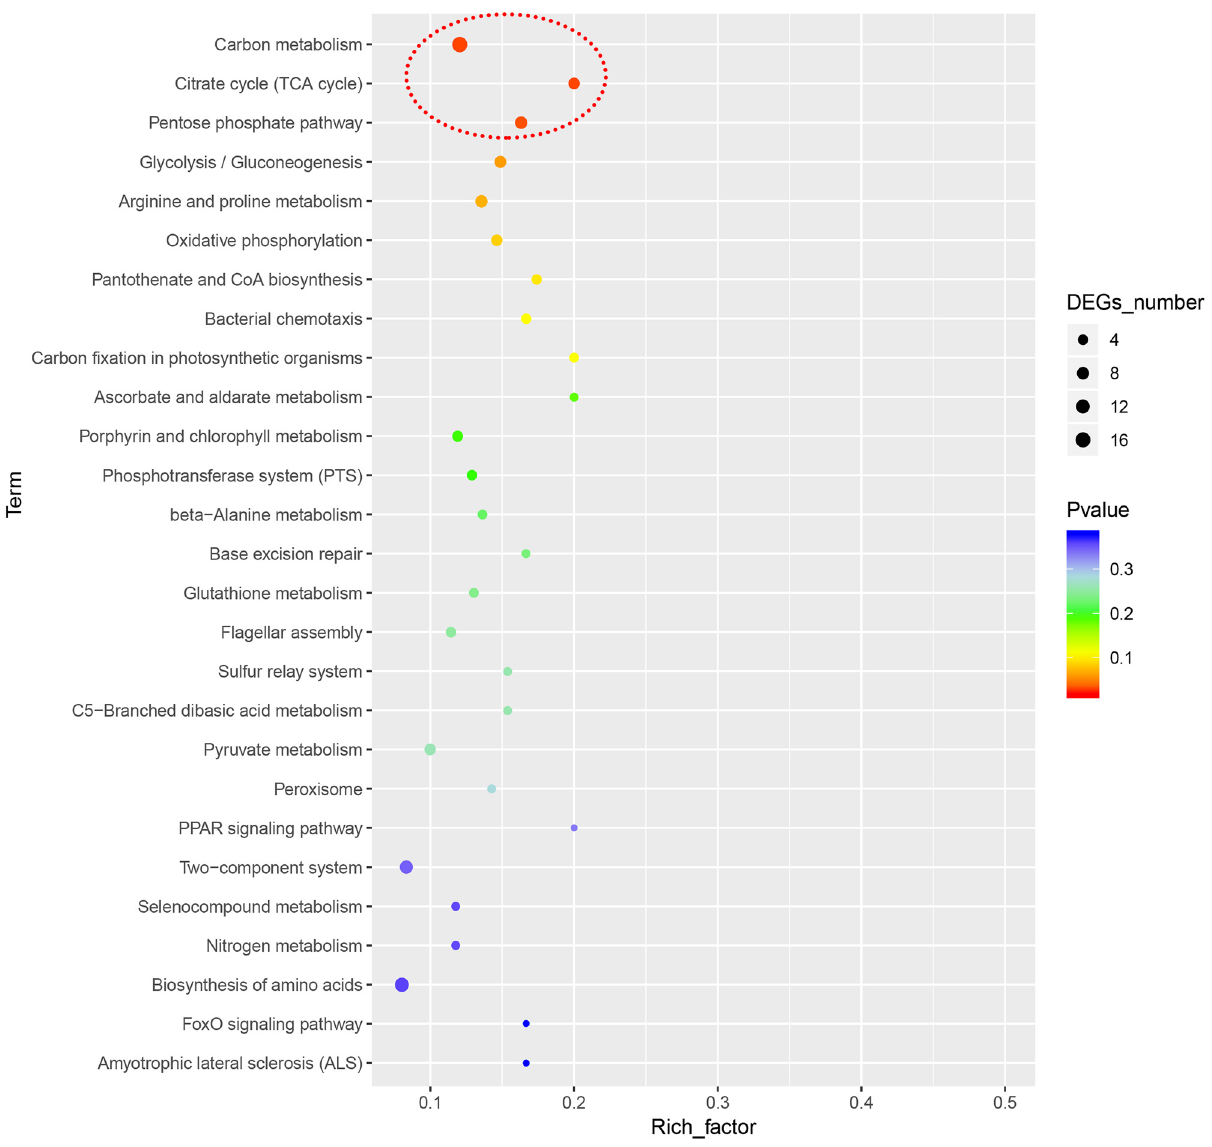
Figure 6: Top pathways enriched in KEGG analysis. A large rich factor indicates a high degree of